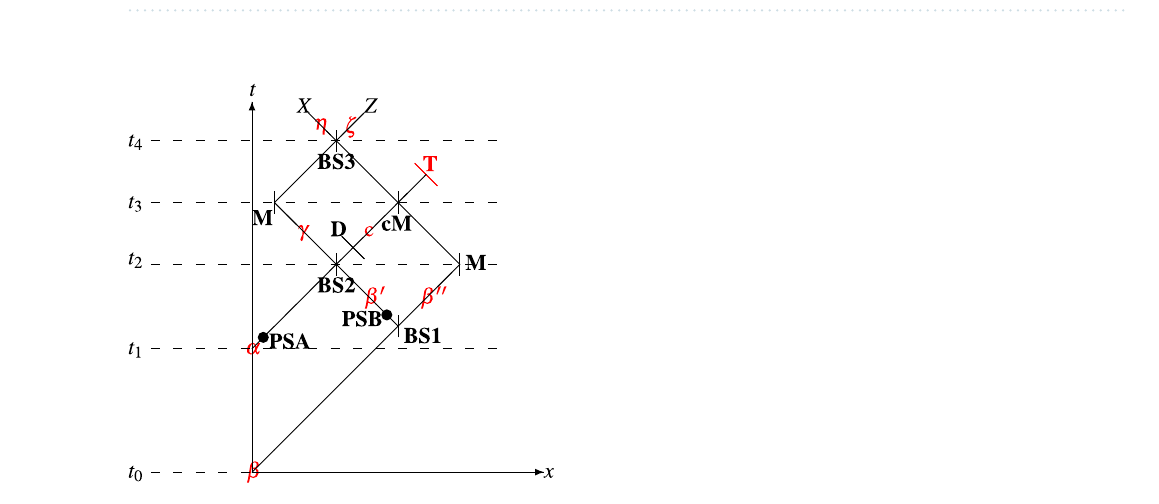
Table 2. Encoding/decoding table of Scheme II . We assume that the polarization state | x ( z ) +� is reflected off the Bob’s PBS , while | x ( z ) −� is passed towards the lower detector D .